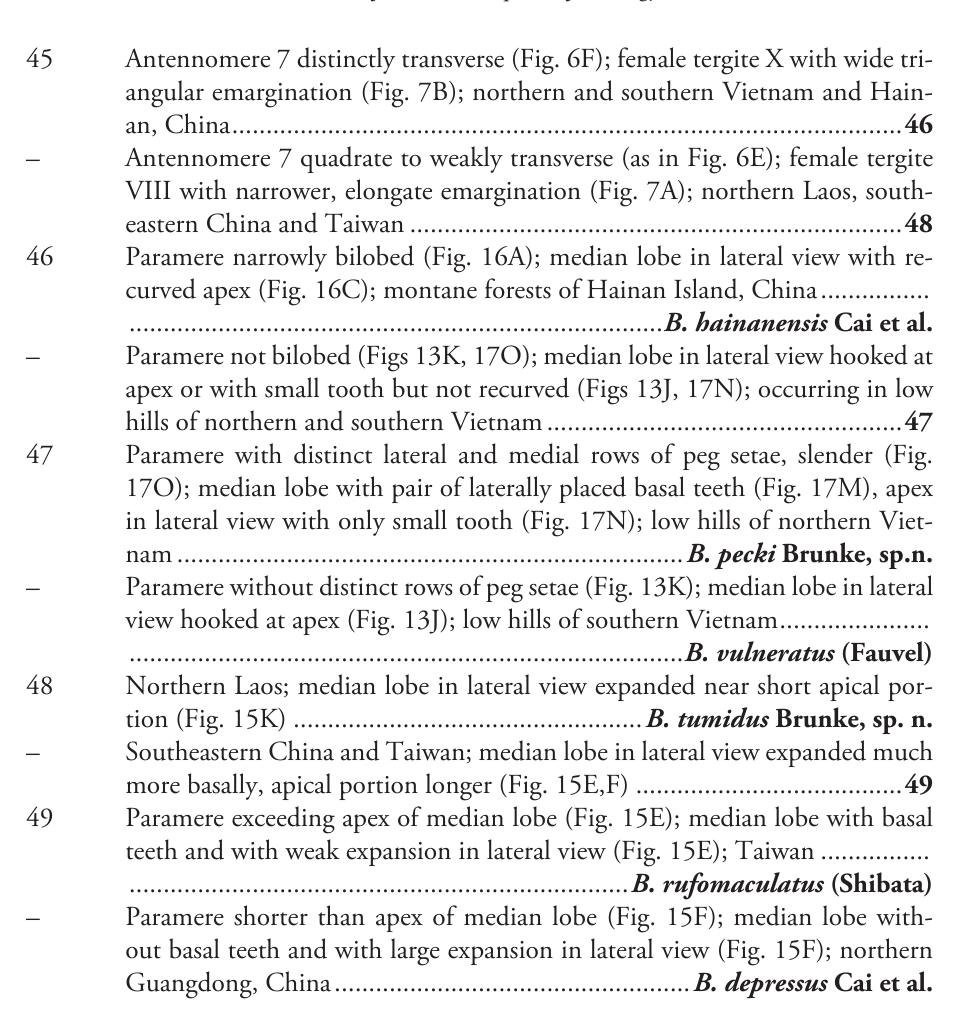
out basal teeth and with large expansion in lateral view (Fig. 15F); northern